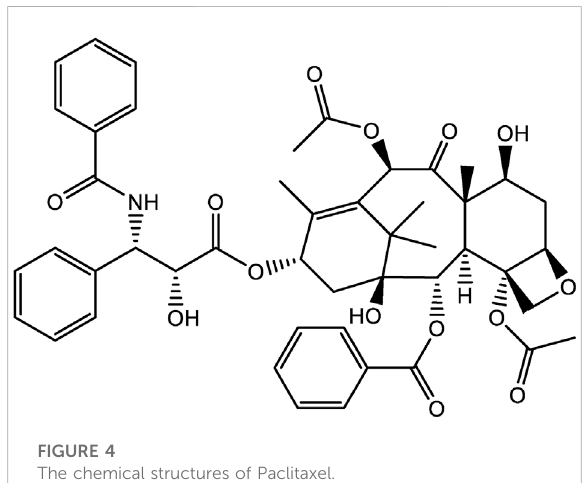
FIGURE 4 The chemical structures of